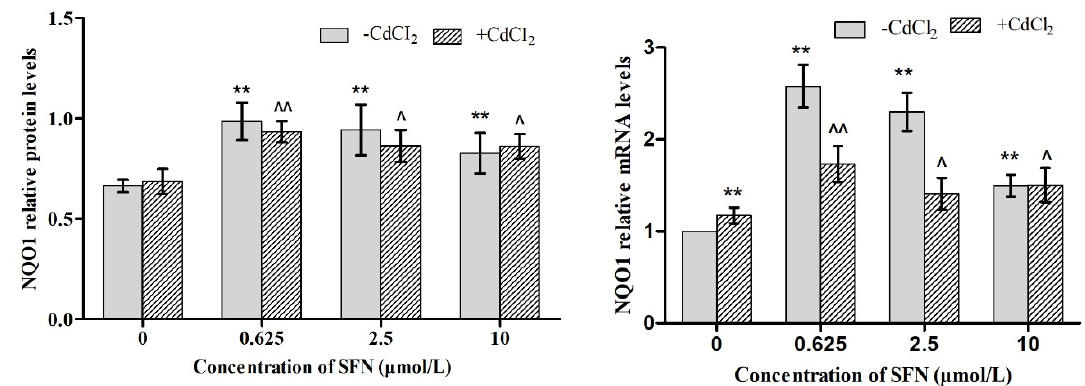
Figure 8. Effects of SFN on Cd induced the relative mRNA and protein expression of NQO1 of the TM4 cells. ** p < 0.01 as compared to the control group, ^ p < 0.05 as compared to the Cd group, ^^ p < 0.01 as compared to the Cd group.